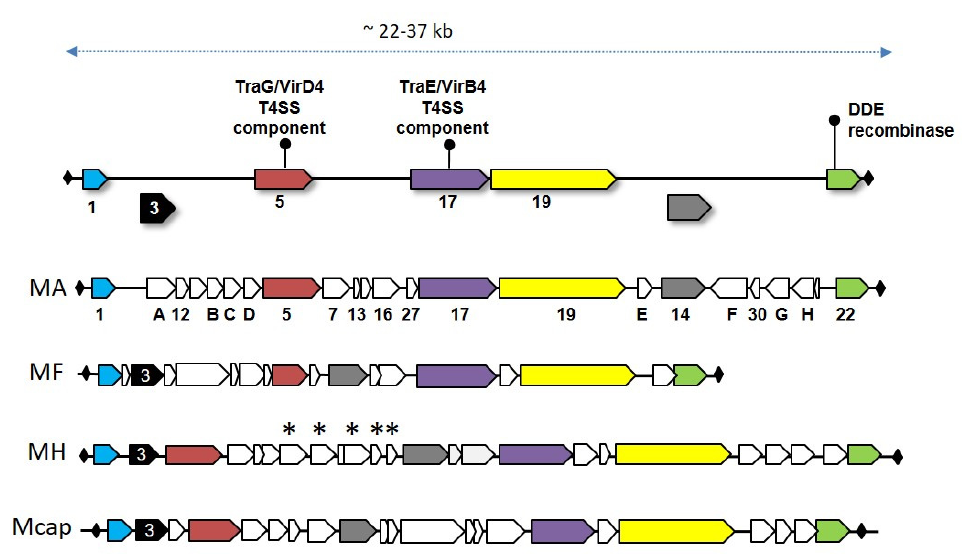
Figure 3. Overall gene organization of Mycoplasma Integrative and Conjugative Element (MICE). MICEs are large GIs whose sizes range from 22–37 kbp and display a set of highly conserved genes across MICEs. These are represented as colored filled arrows with some, less conserved, being represented below the line. Inverted repeats that flank the MICE and are juxtaposed in the circular form are represented by diamonds. Direct repeats (not shown here) are generated upon MICE random integration in the host chromosome. For illustration, representative MICEs of the M. agalactiae strain 5632 (MA), M. fermentans strain M64 (MF), M. hominis strain 4788 (MH), and M. mycoides subsp. capri strain GM12 T (Mcap) are shown. Asterisks represent MICE genes which are specific to M. hominis